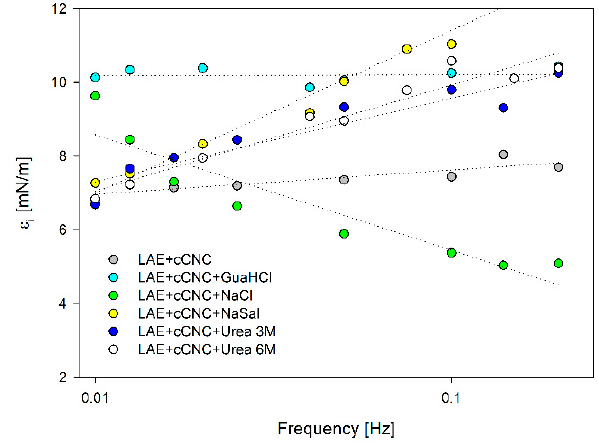
Figure 7. The frequency dependence of the imaginary part of dilational modulus in LAE-cCNC dispersions with 5 mM electrolytes: guanidine hydrochloride, sodium chloride, sodium salicylate and urea at concentrations 3 mol/L or 6 mol/L.